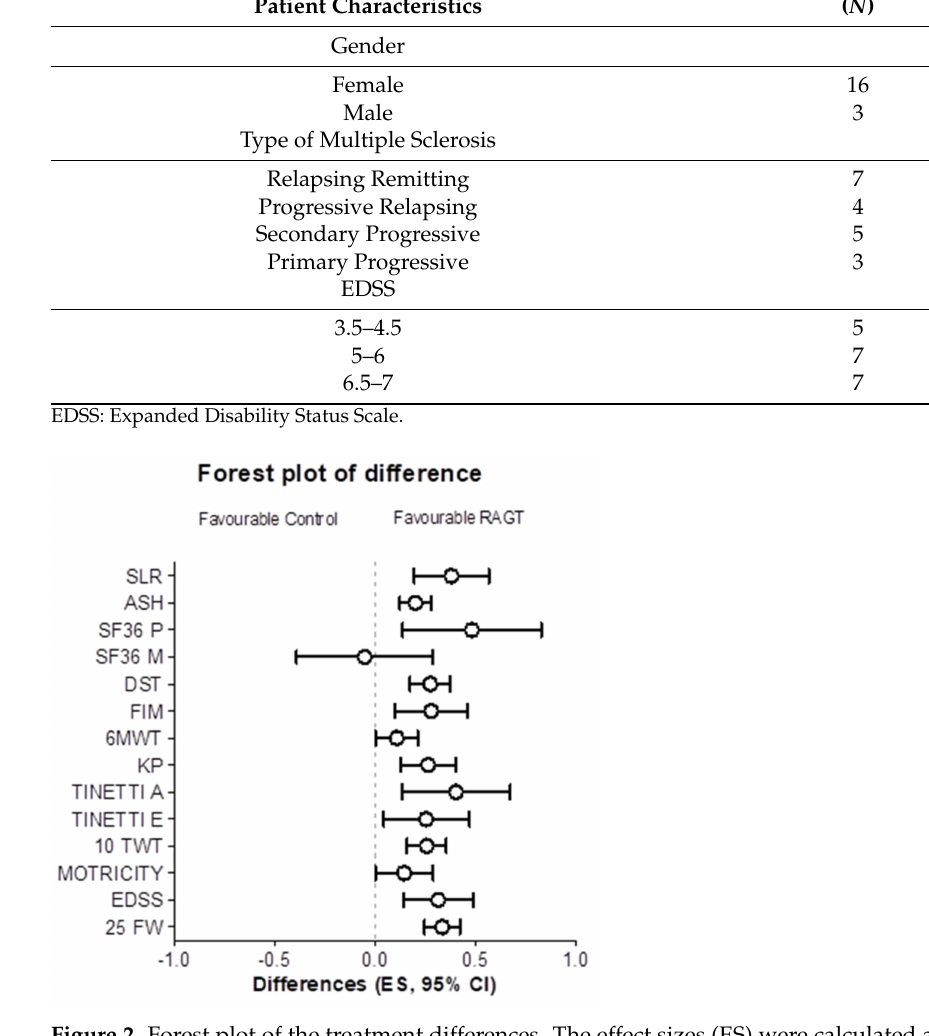
Figure 2. Forest plot of the treatment differences. The effect sizes (ES) were calculated as changes from pre-training for each intervention and then the ES differences between robot assisted gait training (RAGT) and control intervention were computed to create the forest plot. The quantitative report of the ES difference is reported Table